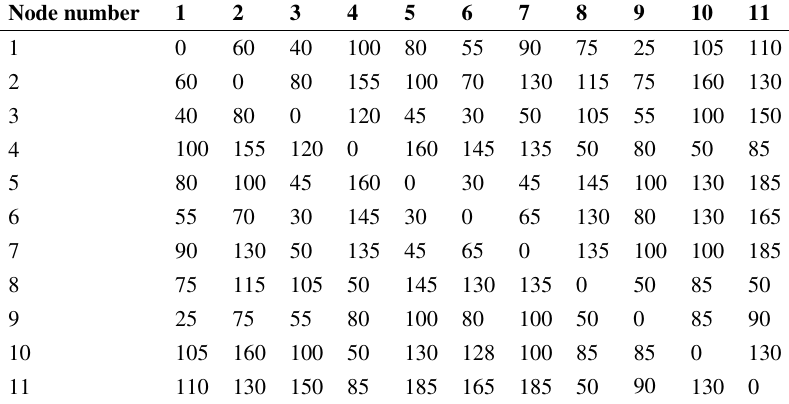
Table 2 Distance between urban nodes (unit: km)